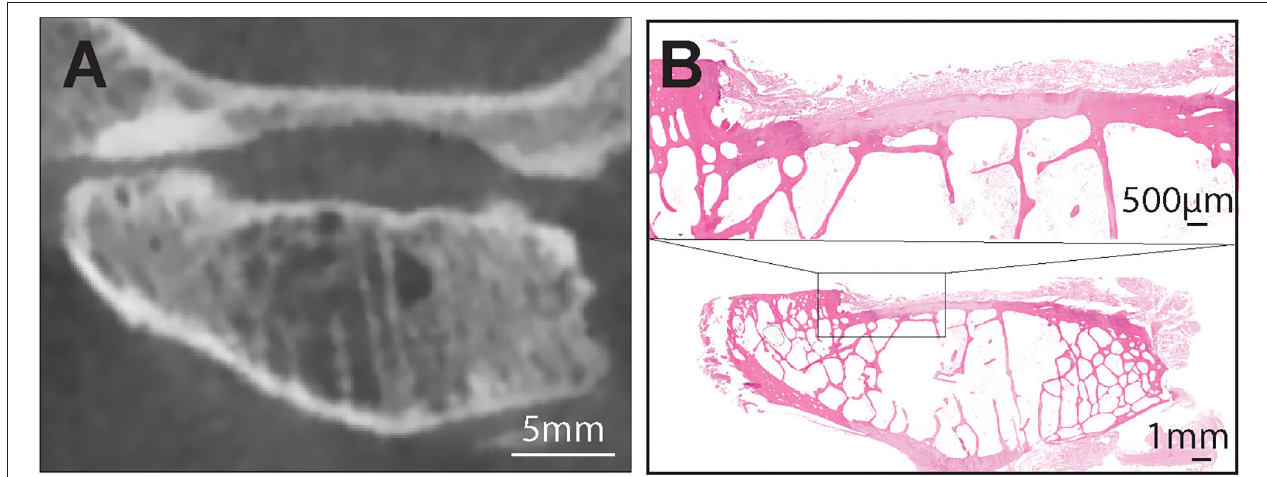
FIGURE 3 | (A) A representative transverse CBCT image of the TMJ of the dog demonstrating joint space alterations and severe articular surface damage at the mandibular head. These alterations included subchondral bone defect, articular cartilage damage and subchondral bone cyst. Note that there was moderate agreement between histologic and radiologic findings of subchondral bone damage and cysts on the mandibular heads (B) . Hematoxilin & Eosin staining of the entire mandibular head with extensive damage of the cartilge and subchondral bone. Note large marrow cavities that could have been misinterpreted on CBCT as subchondral cysts. Bar = 1mm. Inset: the exposed subchondral bone is covered by loose fibrous connective tissue. There is no evidence of bone sclerosis despite the extensive damage to cartilge. Bar = 500 µ